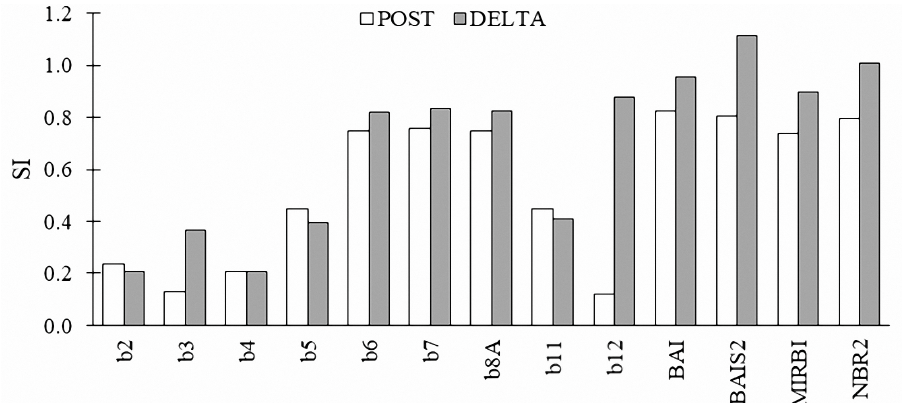
Figure 4. Separability of classes in bands and indices for POST and DELTA datasets.